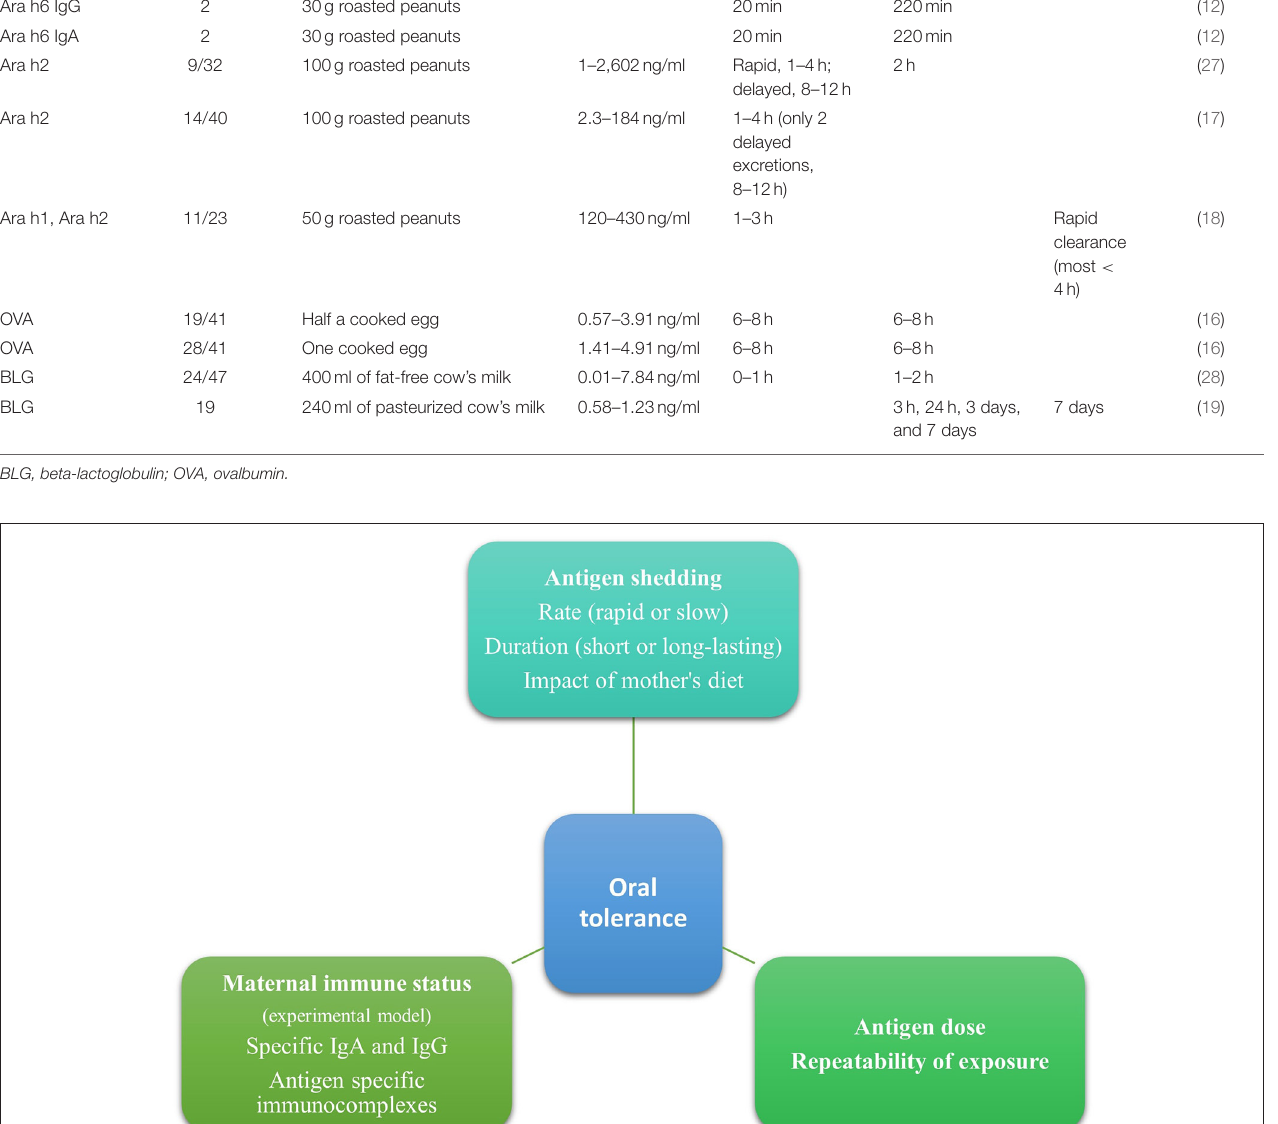
of free antigens, suggesting that they are excreted by a different mechanism